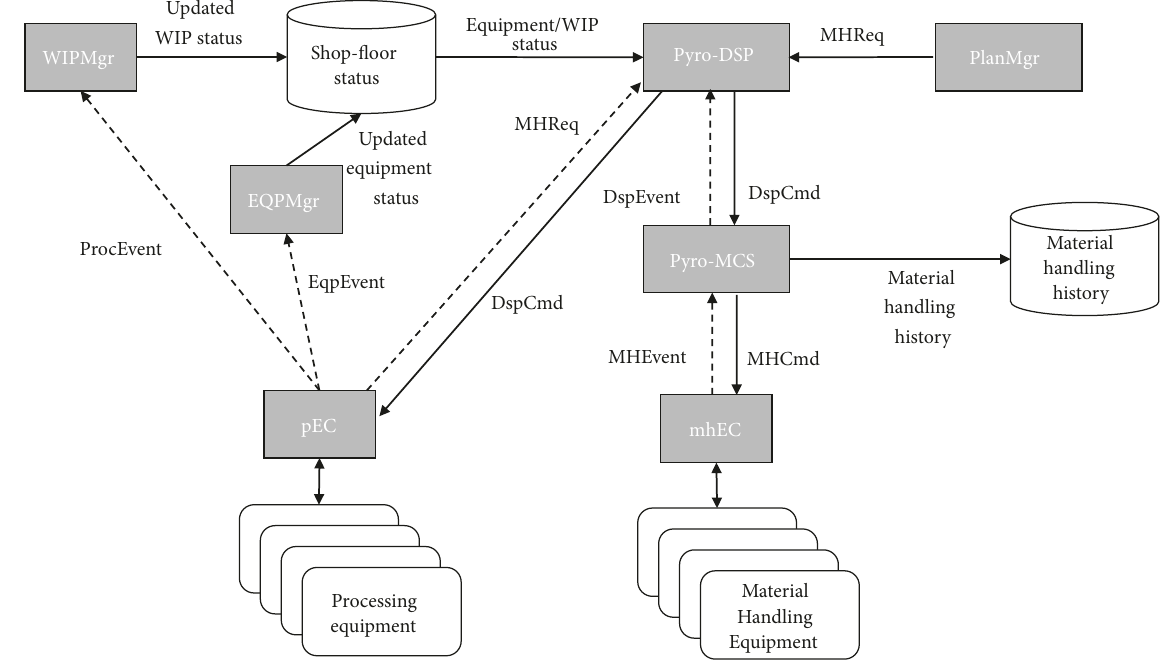
Figure 1: Functional architecture of the pyroprocessing execution system